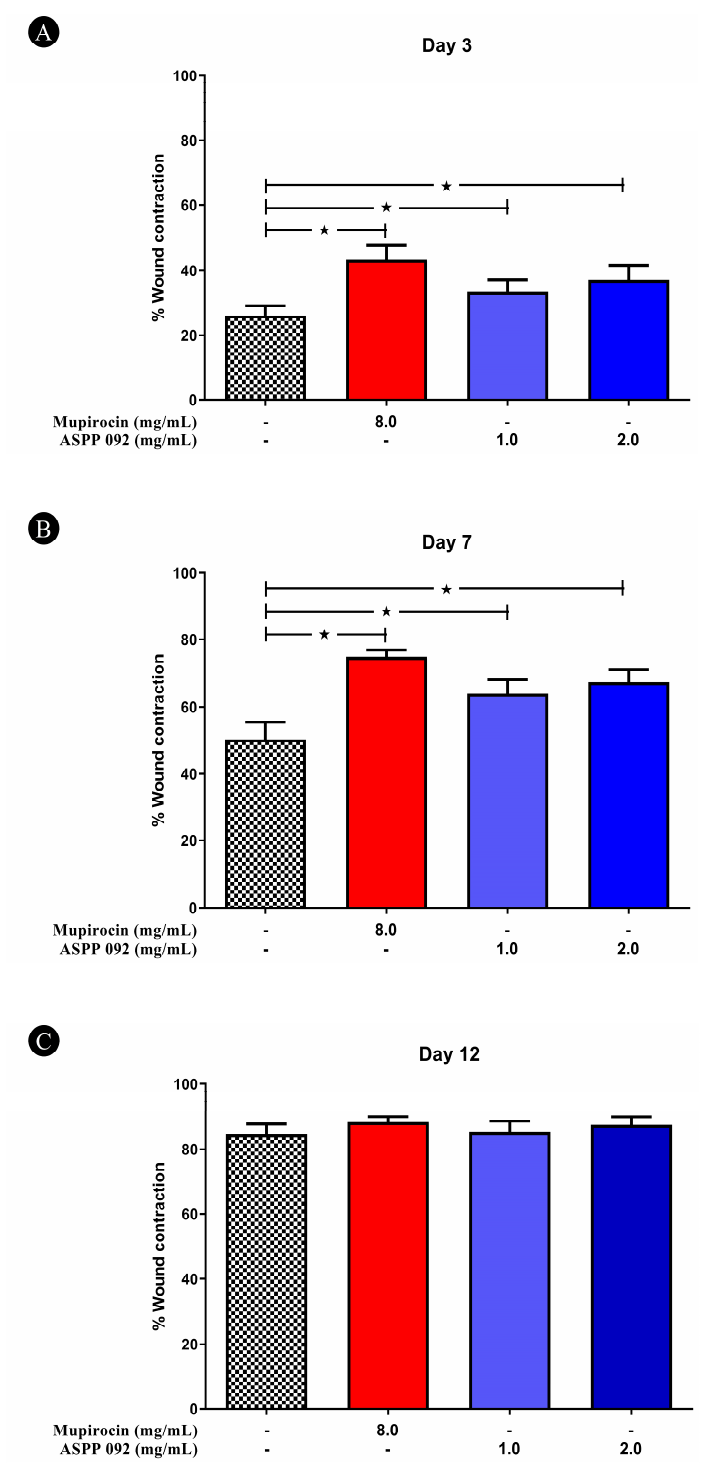
Figure 3. Percentage of wound healing at different time intervals. The experimentally induced wounds were treated with either mupirocin or ASPP 092 at concentrations of 1 mg/mL and 2 mg/mL. A vehicle control group was also maintained. The percentage of wound healing at different time points, including ( A ) Day 3, ( B ) Day 7, and ( C ) Day 12, are represented. The data obtained for each time point are represented as mean + SEM. * p < 0.05 was considered to be statistically significant.